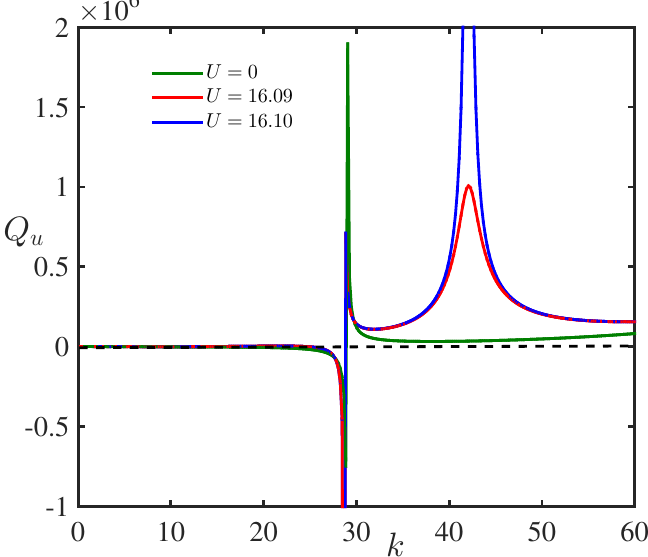
Figure 13. (Color online) Variation of the nonlinear coefficient Q u versus wavenumber k for different values of wind speed in the case of upper branch of dispersion